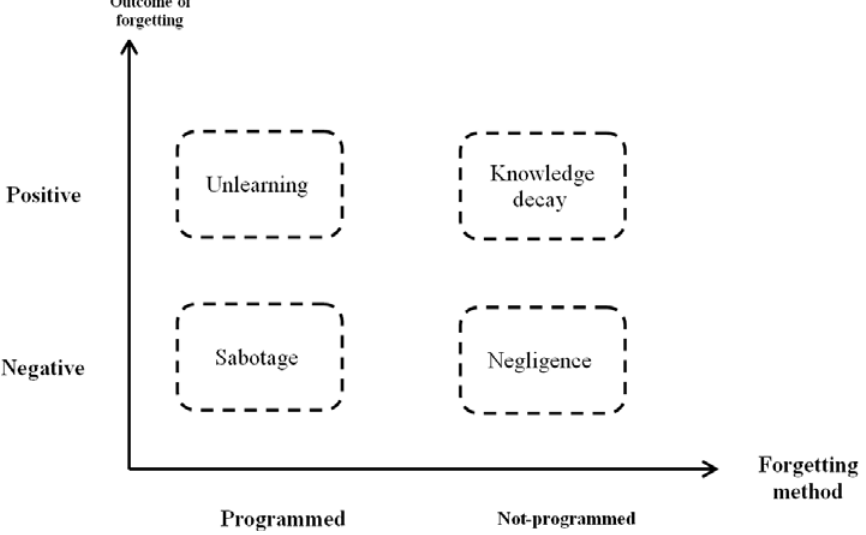
Fig. 2. Aspects of organizational